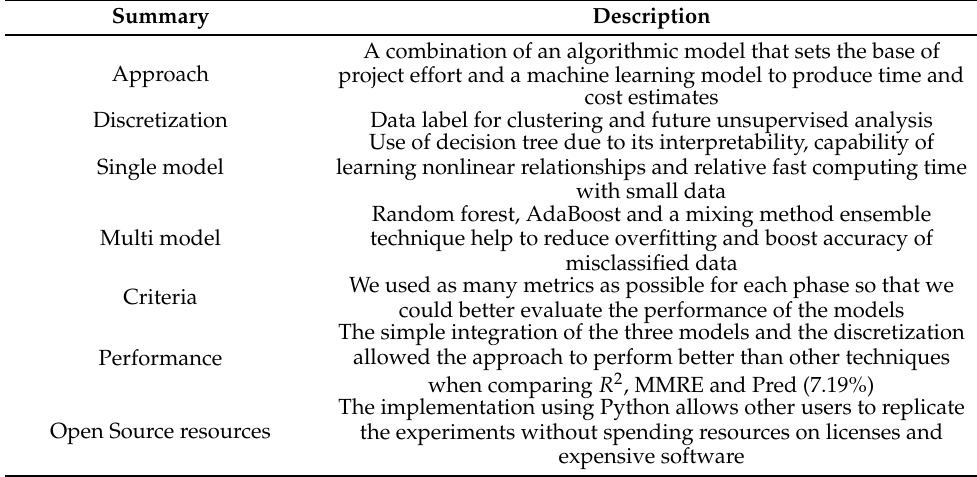
Table 18. Summary of proposal’s innovation and